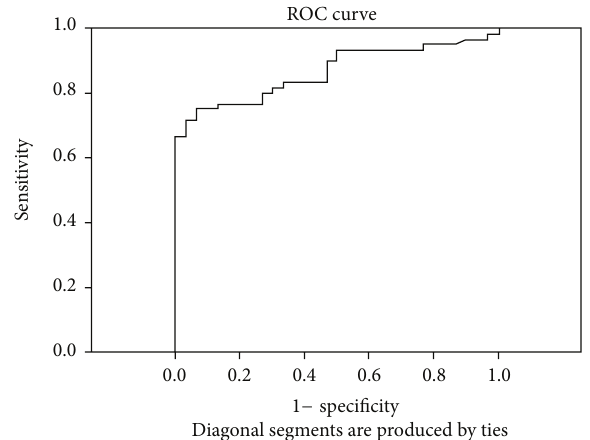
Figure 1: The ROC curve for S-calprotectin indicating the optimal cut-off value of 475.00 ng/mL (sensitivity 75.0%, specificity 93.3%).